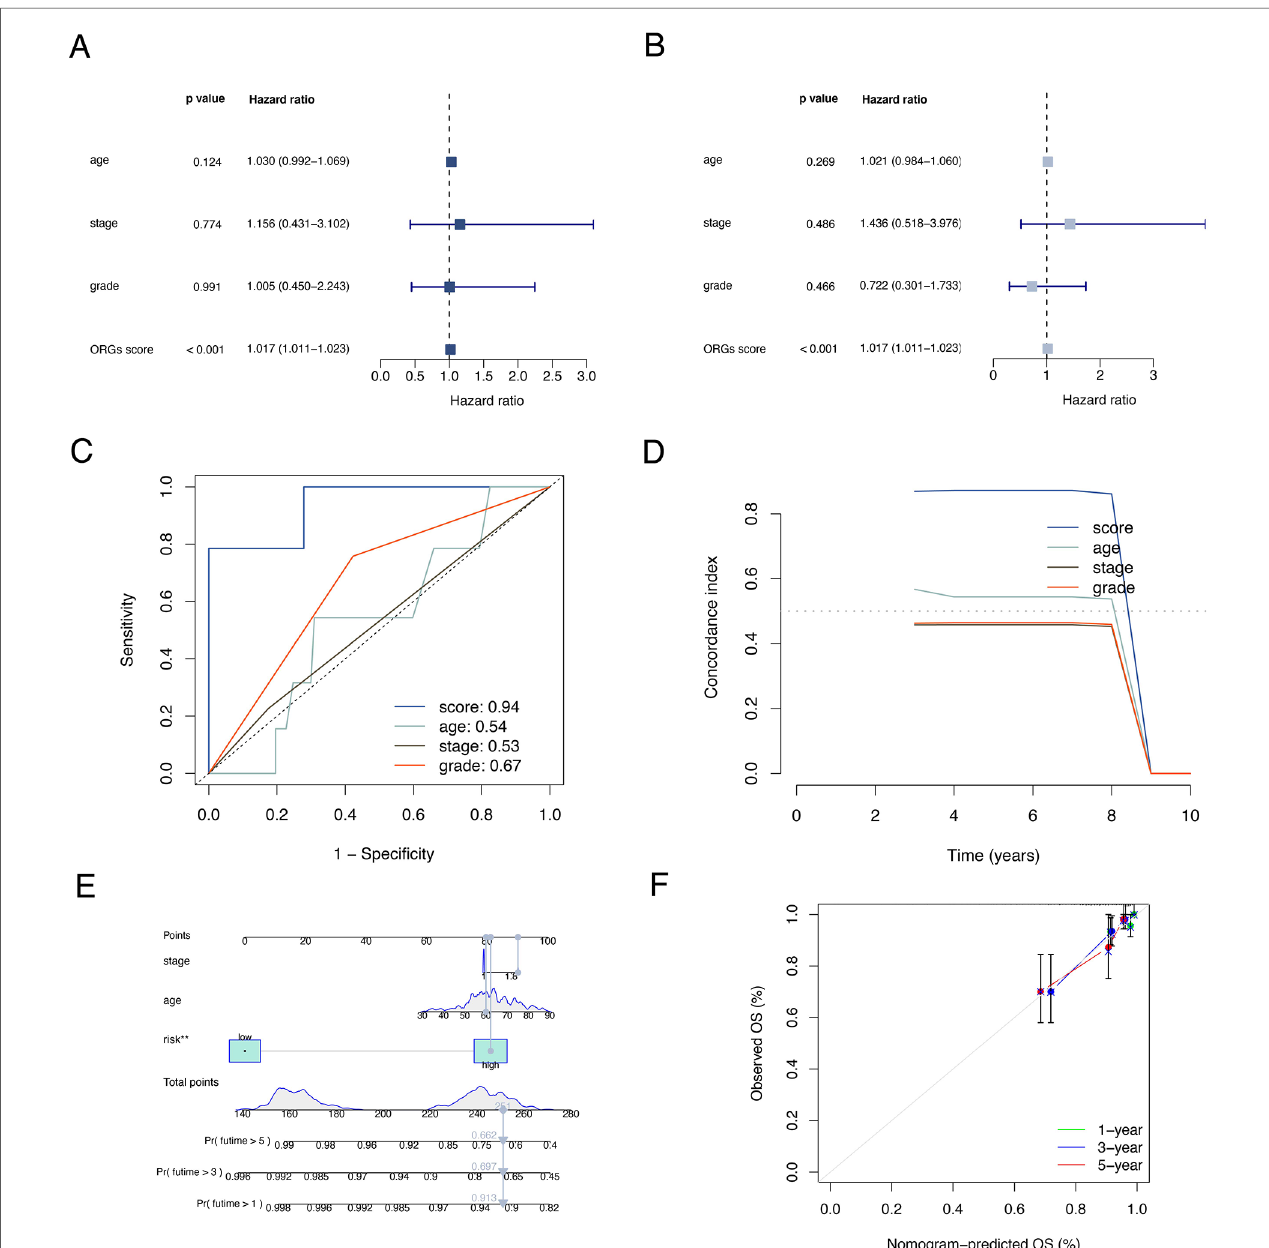
FIGURE 5 Correlation analyses of clinical features. Univariate ( A ) and multivariate ( B ) Cox regressions of ORGs score, age, tumor grade, and FIGO stage. The ROC ( C ) and C-index ( D ) of ORGs score, age, tumor grade, and FIGO stage. ( E ) The nomogram for predicting prognosis of EEC patients. ( F ) The calibration curves of the nomogram. ORGs, obesity-related genes. FIGO, the International Federation of Gynecology and Obstetrics. ROC, receiver operating characteristic curve. EEC, endometrioid endometrial